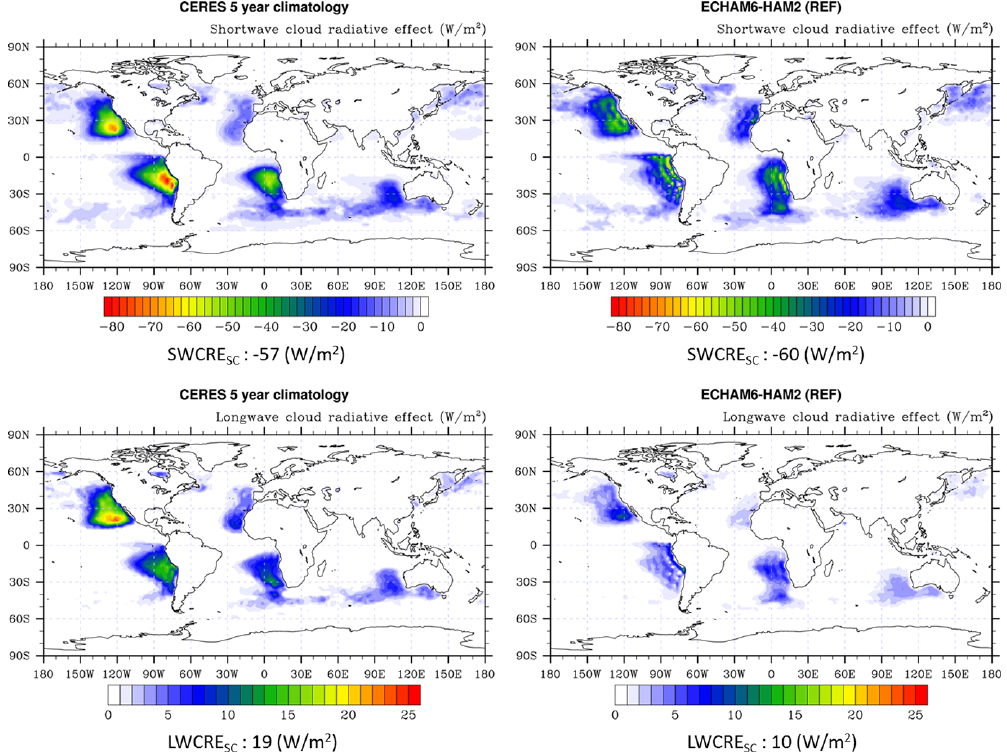
Figure 7. Shortwave and longwave cloud radiative effect in stratocumulus cloud regions in the reference simulation and a 5-year CERES climatology. Values below each panel are in-regime